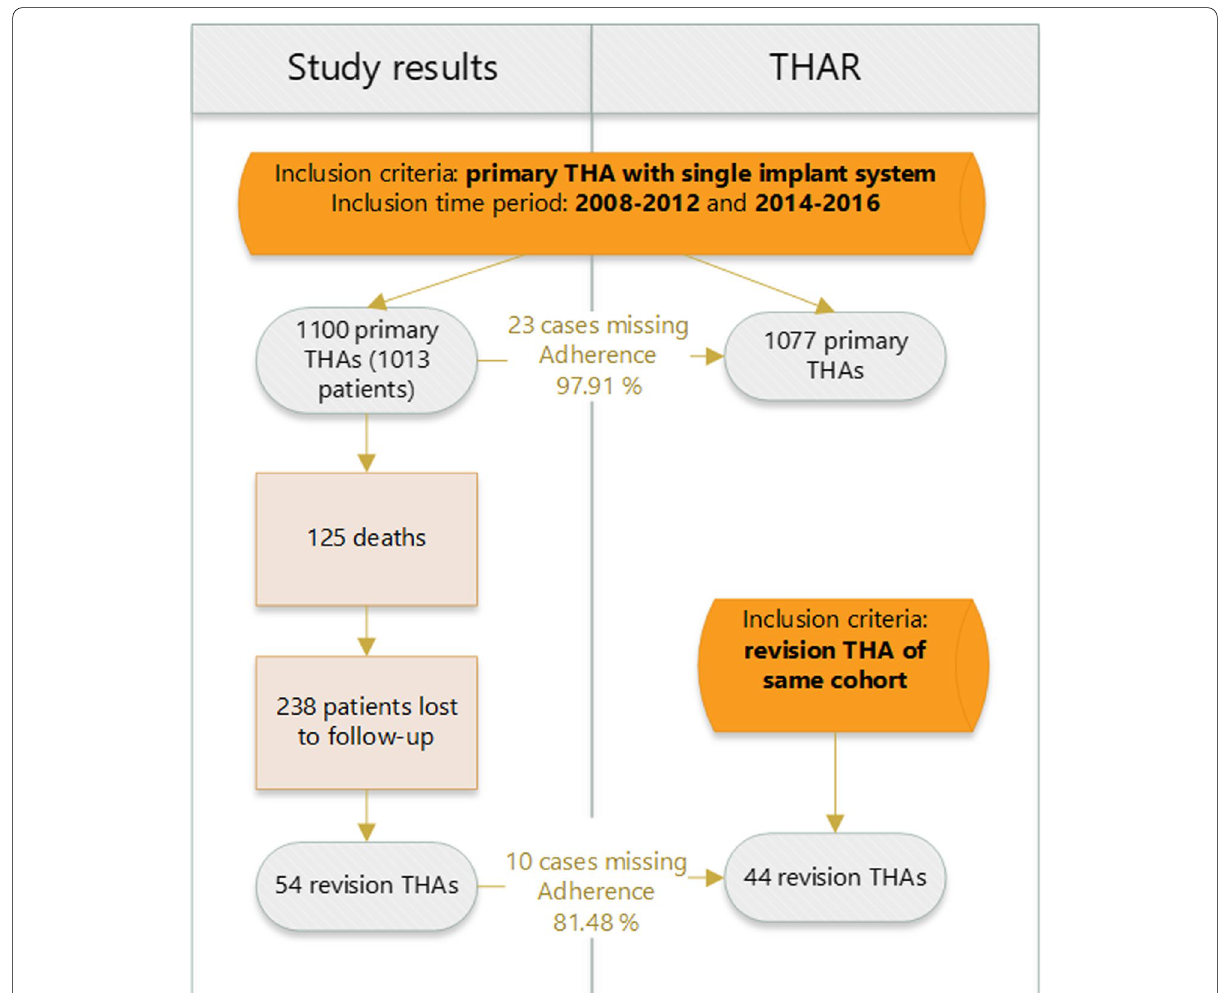
Fig. 2 Flow diagram for prospective clinical follow-up of revision surgeries. THA: Total hip